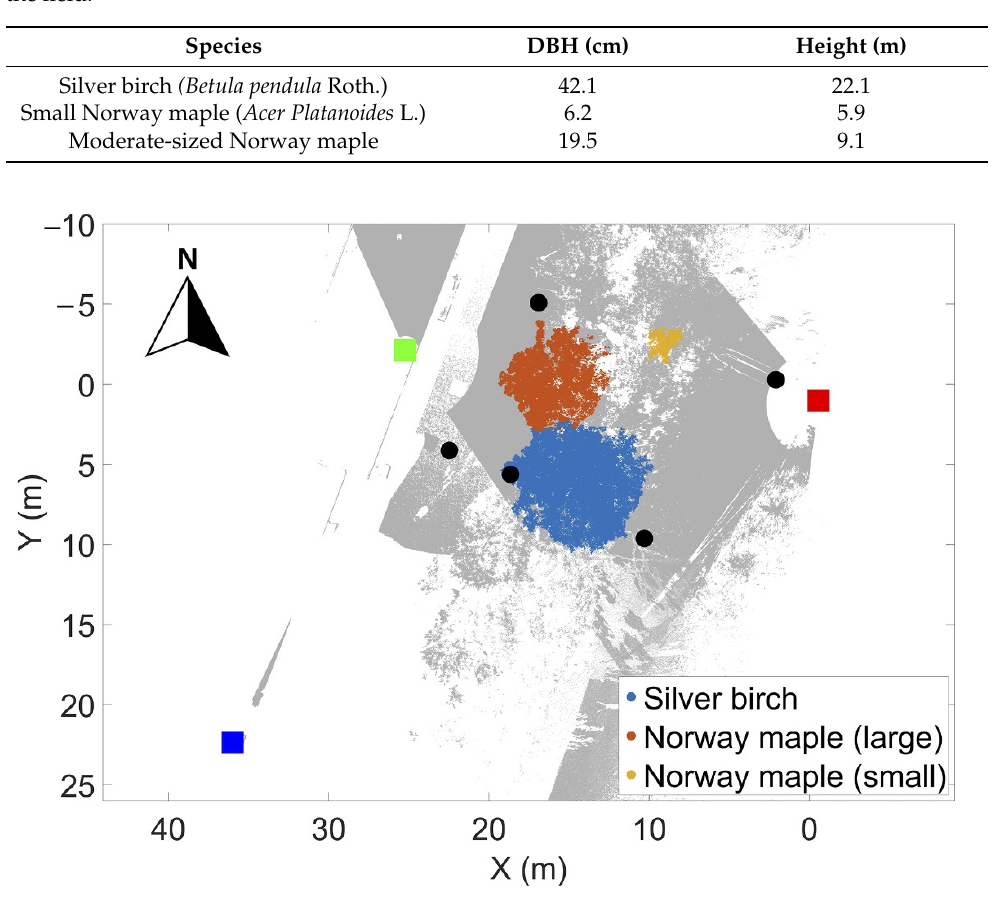
Figure 1. The measurement configuration in August 2016. Scanner locations are marked with colored boxes, being the FARO Focus X330 (red); FARO Focus 3D 120 S 1 (dark blue); and TRIMBLE T5X (green). The gray points denote the combined measured point cloud of all three scanners viewed from above. The trees monitored are marked with different colors in the figure; in addition, the small Norway maple is highlighted with a red rectangle. The five reference sphere locations are marked with black circles in the figure.